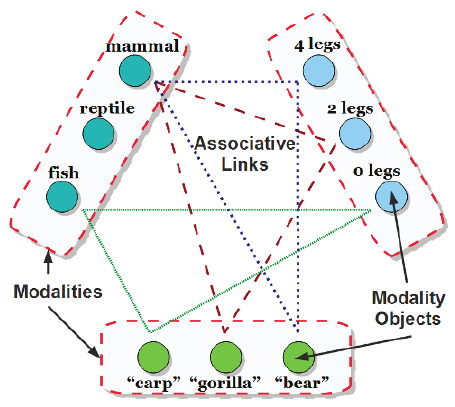
Figure 2. The structure of DAIM: shown is a subset of the structures acquired during the training process. Associative links are formed between the objects of modalities as these conjunctions are experienced. For example, the animal with label ”gorilla” has been encoded as a con- junction of mammal and 2 legs with this